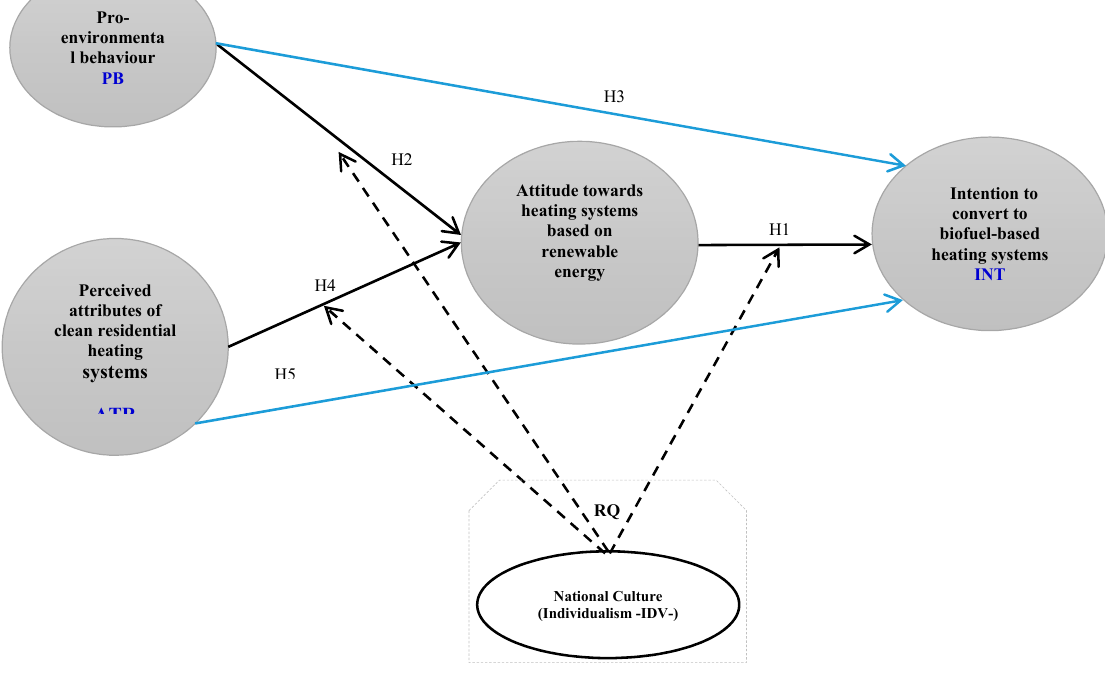
Figure 1. Proposed model. Source: Created by authors.